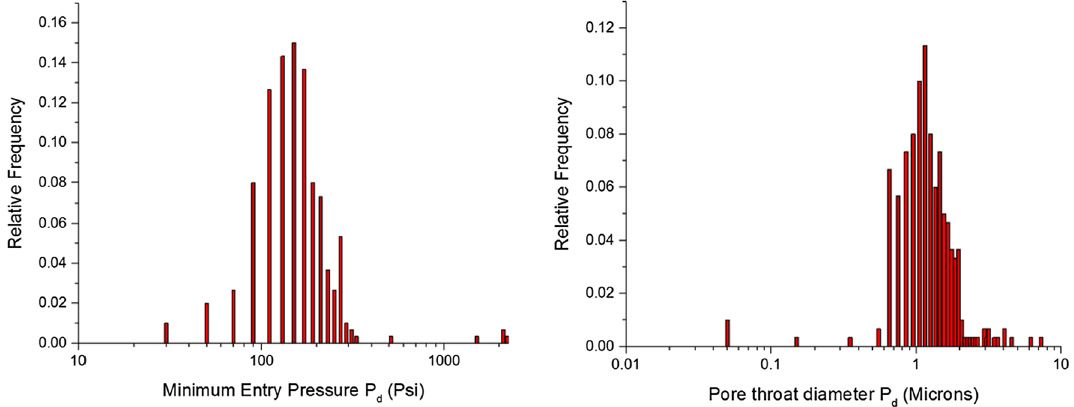
Fig. 4 Frequency of occurrence of all P d values for Thomeer matching, indicating the maximum pore throat distribution in all core plugs (left), and derived maximum pore-throat diameter (µm) (right)